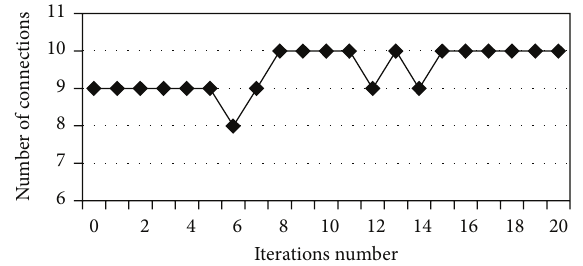
Figure 7: Number of connections at all iterations on second layer.